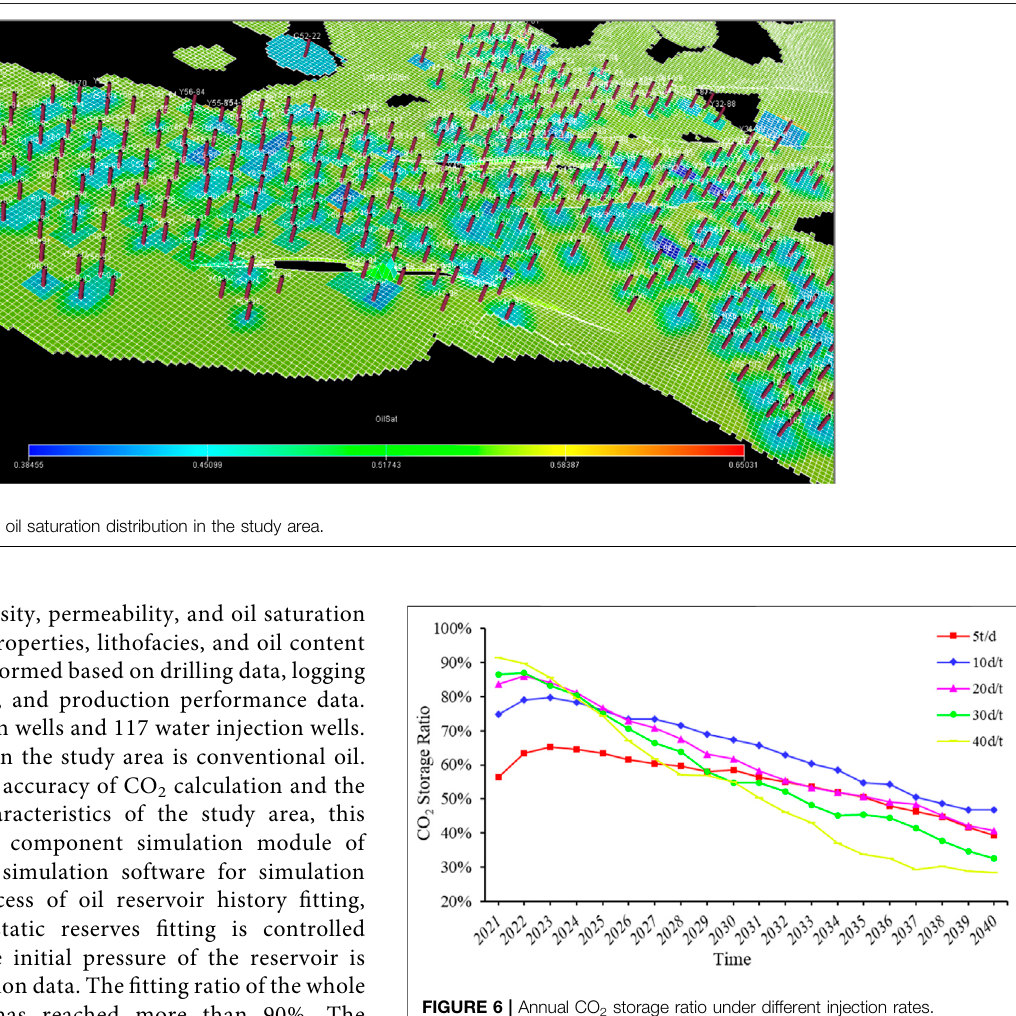
FIGURE 6 | Annual CO 2 storage ratio under different injection